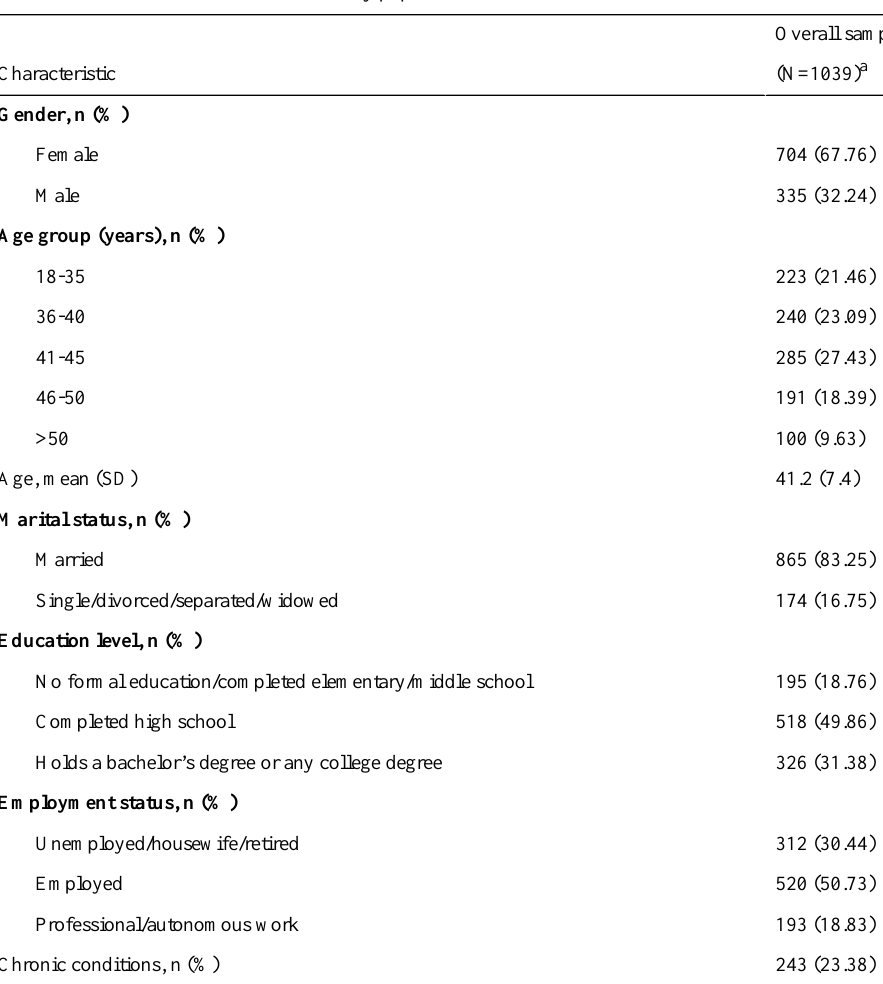
Table 1. Selected characteristics of the study